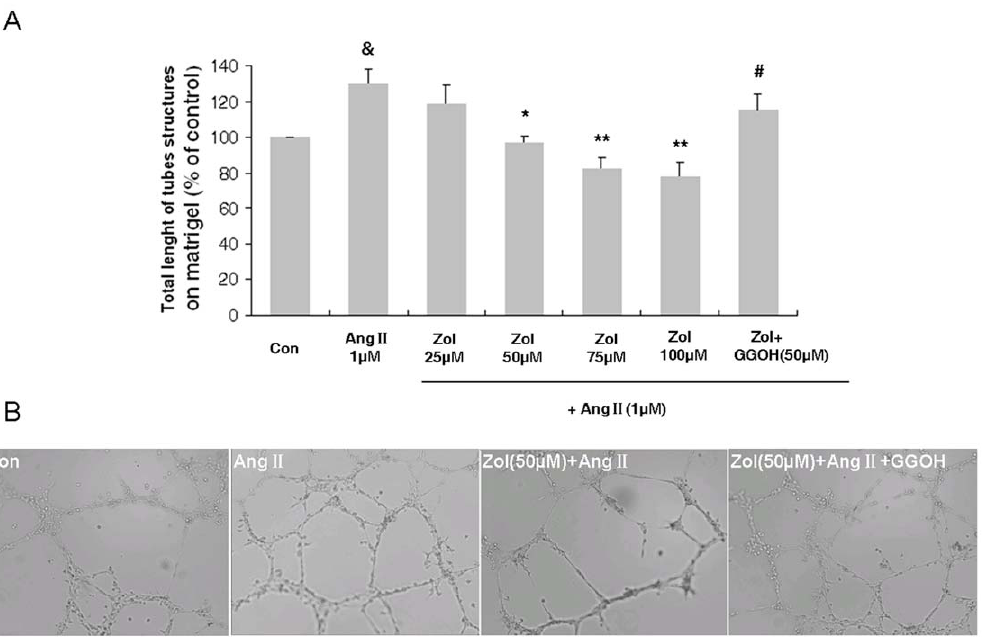
Figure 5. Effect of Ang II and Zol on EPC invitro tube formation ability. Ang II increased EPC in vitro tube formation ability, while Zol dose dependently decreased cell in vitro tube formation and GGOH showed reversal effect. A: Quantitative analysis of total length of the tubes formed on Matrigel for each experimental group. B: Light micrographs showing typical tubules (200 6 ). Results are the mean 6 SD, n=5. &P , 0.01 vs. control group; * P , 0.05 vs. Ang II group; ** P , 0.01 vs. Ang II group; # P , 0.05 vs. 50 m M Zol + Ang II